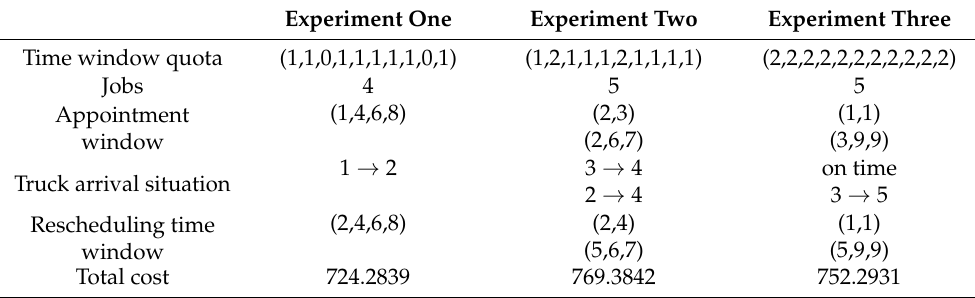
Table 1. The actual arrival and re-scheduling situation of a certain truck